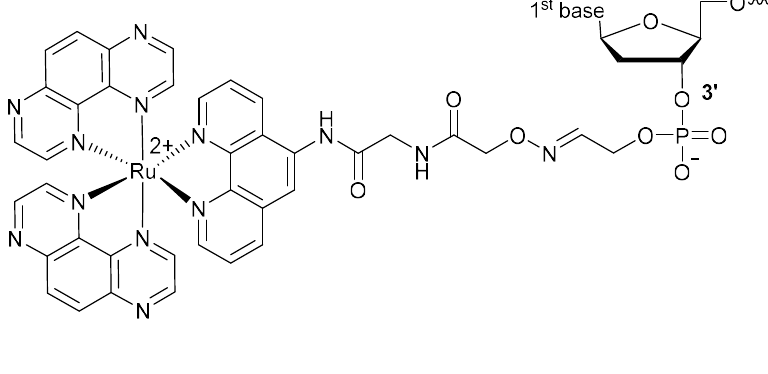
Figure 18. Structure of Ru-ASO and its complementary sequence [145].